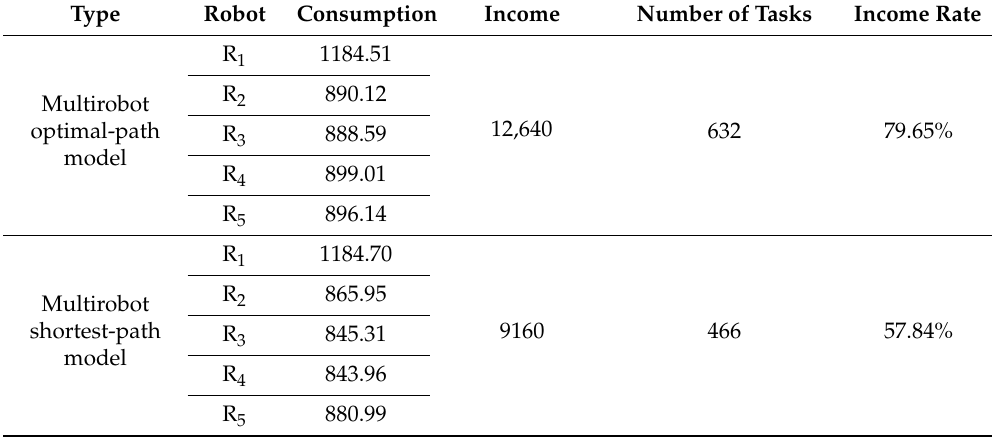
Table 4. Comparison of task-planning paths for a space-robot cluster with a total energy of